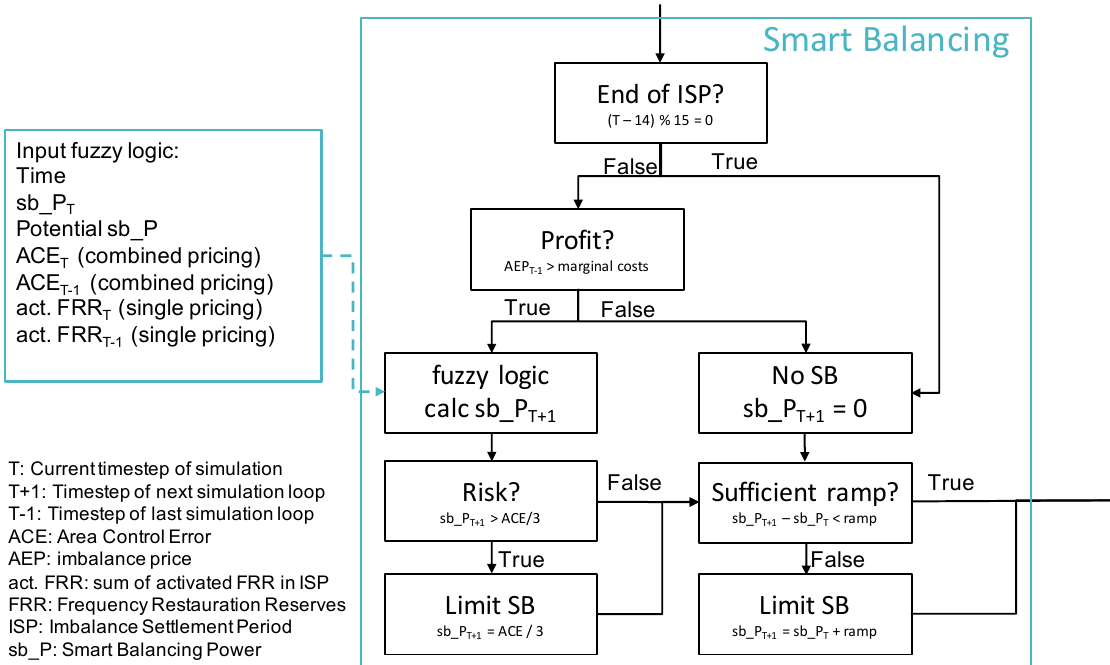
Figure 5. Details of smart balancing calculation in the